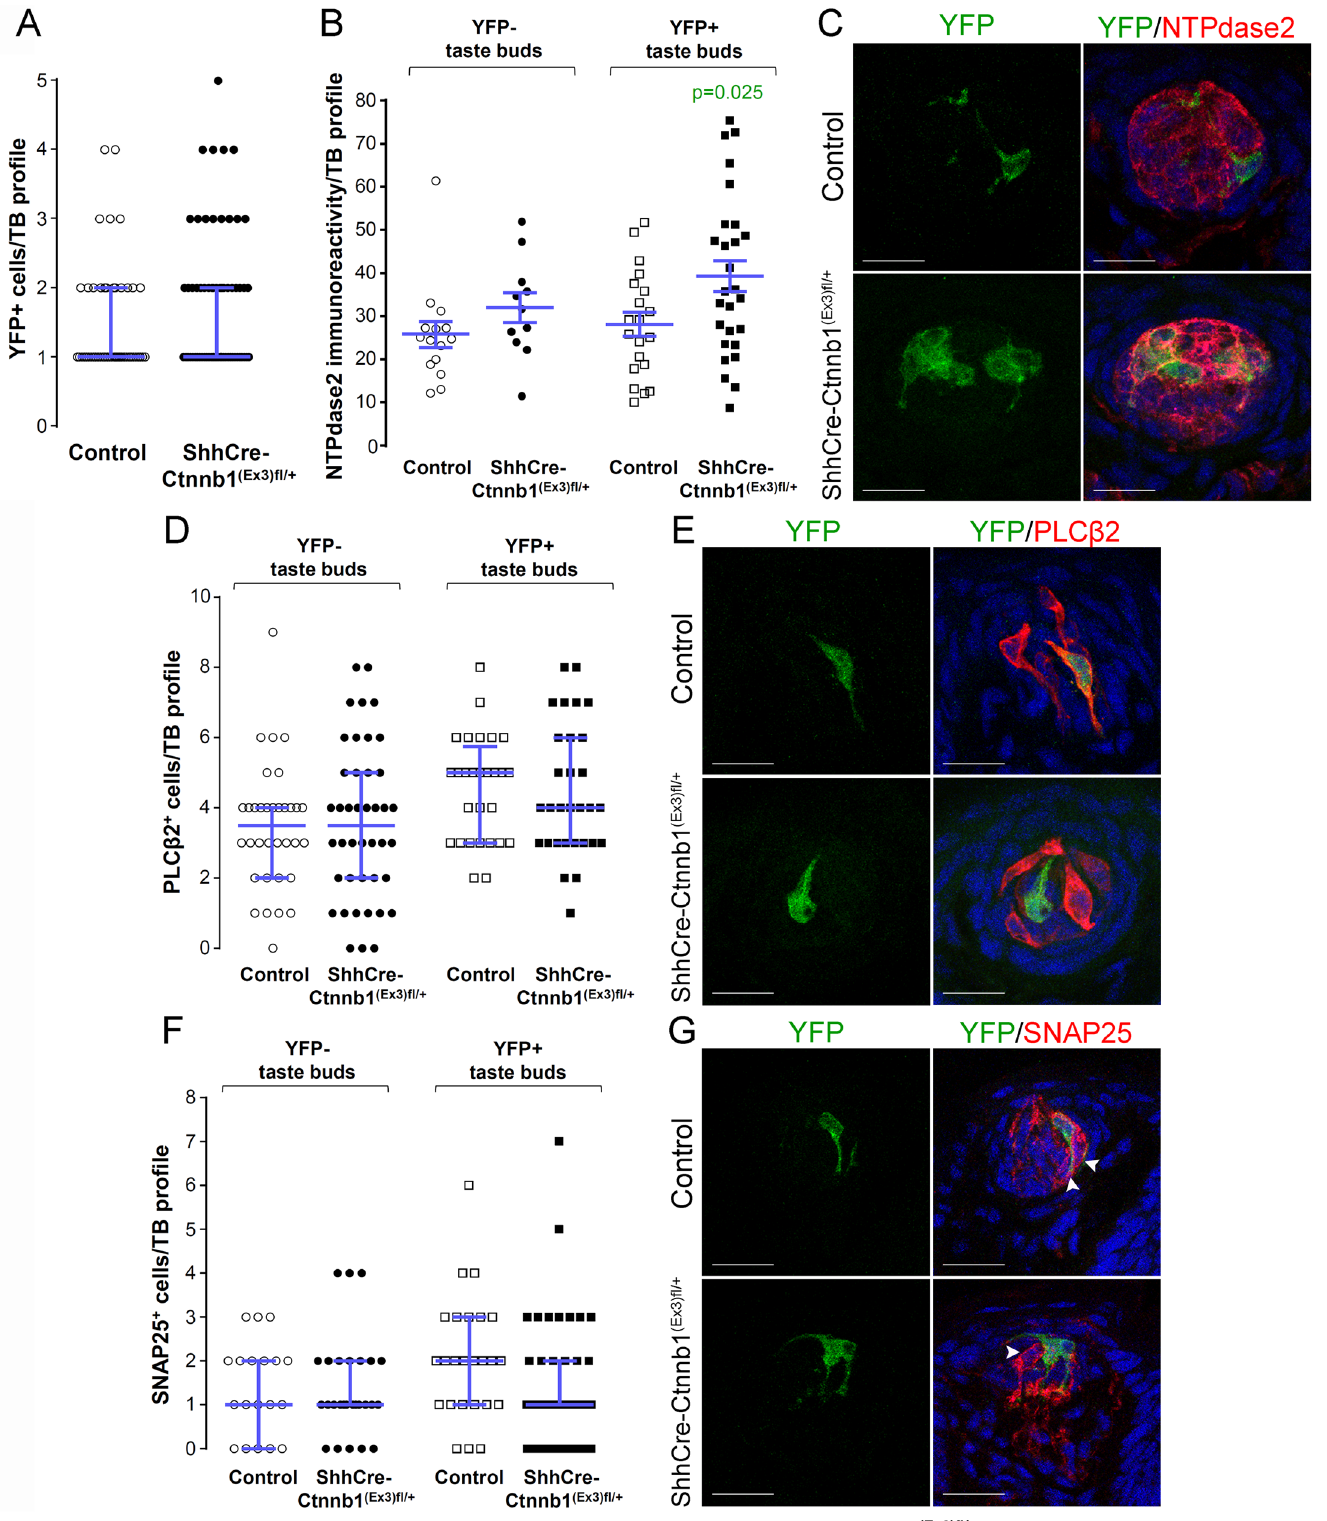
Fig 7. Stabilization of β -catenin in Shh + precursor cells biases FFP taste cell fate. ShhCreERT2;Ctnnb (Ex3)fl/+ ;R26R-YFP mutant mice and their control counterparts (ShhCreERT2;R26R-YFP) were gavaged with tamoxifen daily for 8 days, and tongues harvested 14 days after the last dose. A. The number